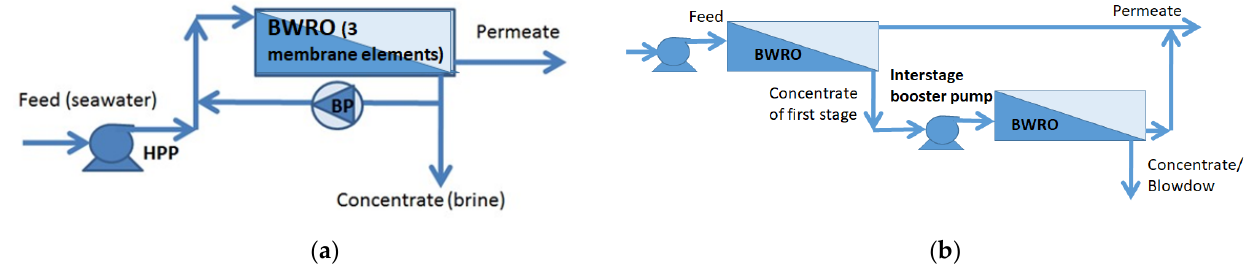
Figure 1. Conceptual diagrams of two configurations of brackish water reverse osmosis (BWRO) systems: ( a ) closed circuit desalination (CCD); ( b ) conventional desalination configuration.